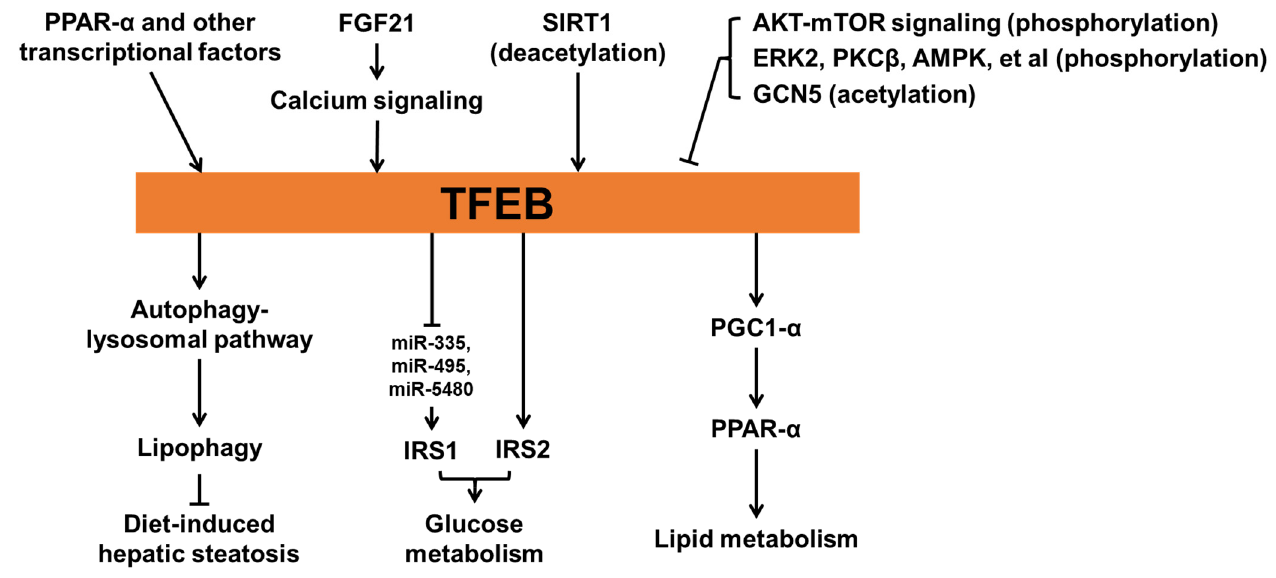
Figure 3. The role of TFEB in metabolic homeostasis.